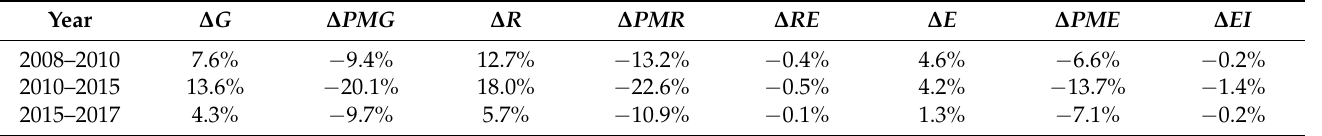
Table A2. Decomposition results in China over different periods (unit: